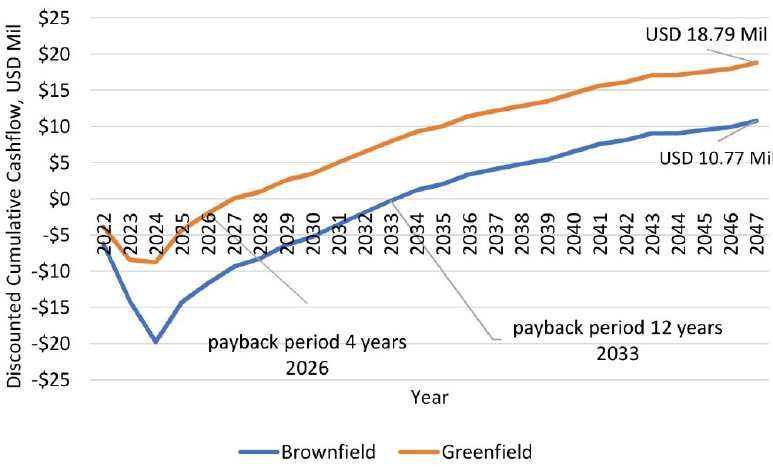
Figure 8. Greenfield vs brownfield-discounted cumulative cashflow.